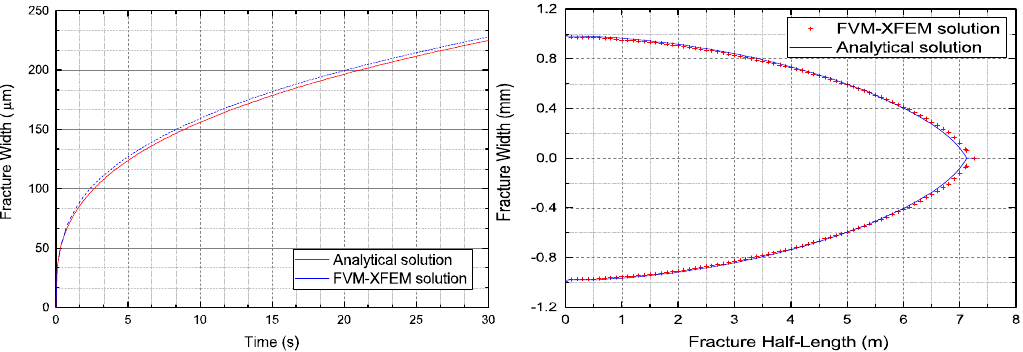
Figure 8. Comparison of the numerical and analytical solutions regarding: ( left ) the fracture width at the crack mouth and ( right ) the fracture width profile.